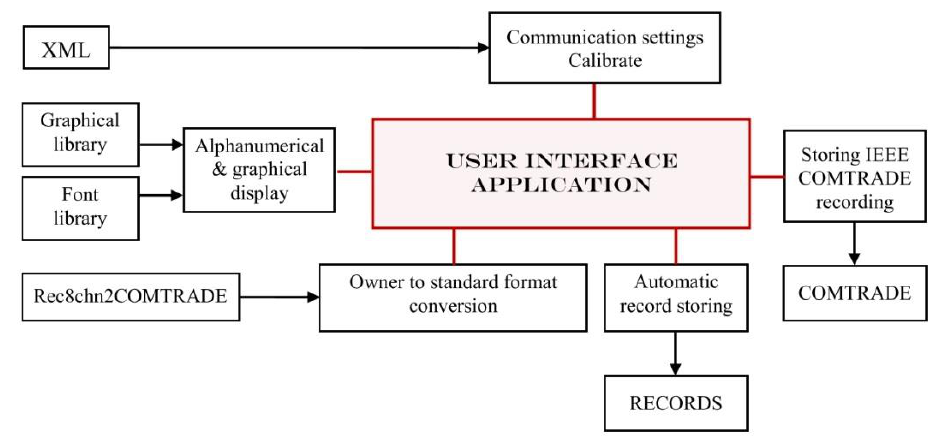
Figure 6. Interconnection of user interface resources.